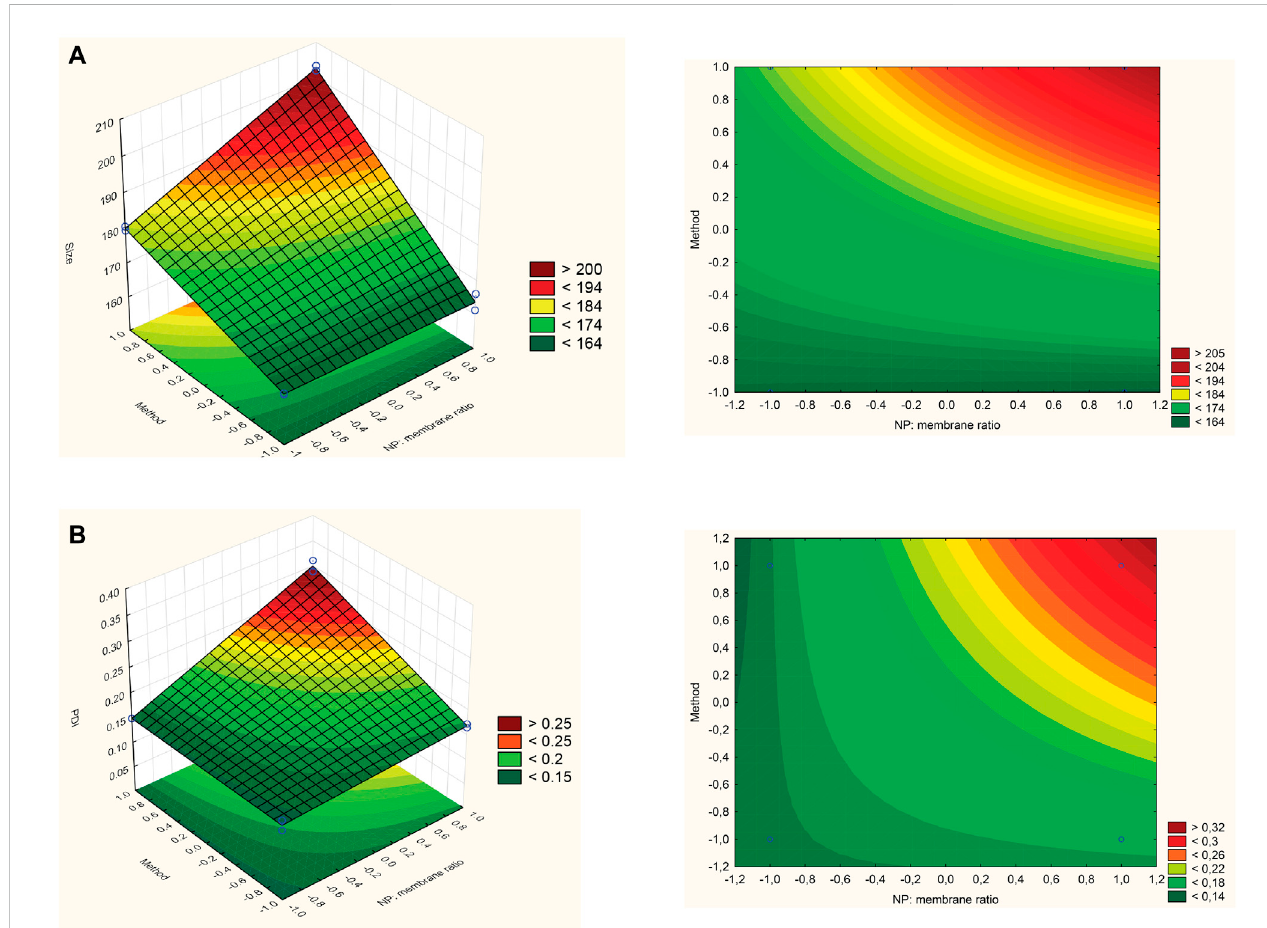
FIGURE 3 Response surface and contour plots. The effect of NP: membrane ratio and method on (A) nanostructures size and (B) nanostructures PDI.